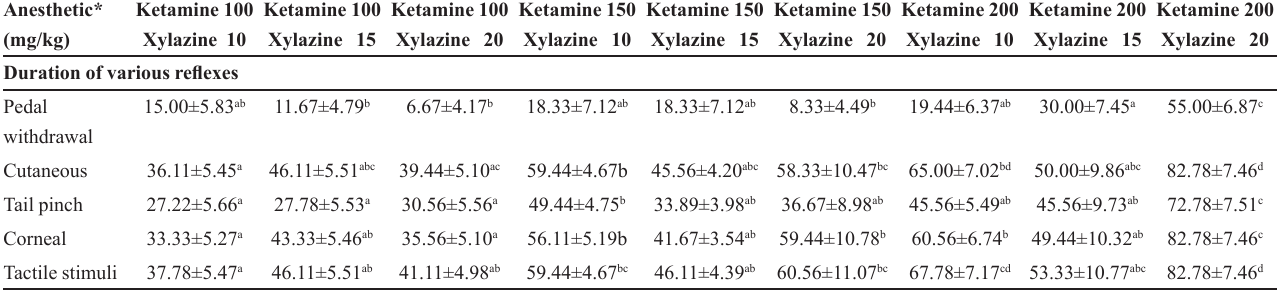
TABLE II - Comparison of duration of various reflexes using different doses of ketamine/xylazine in BALB/c mouse